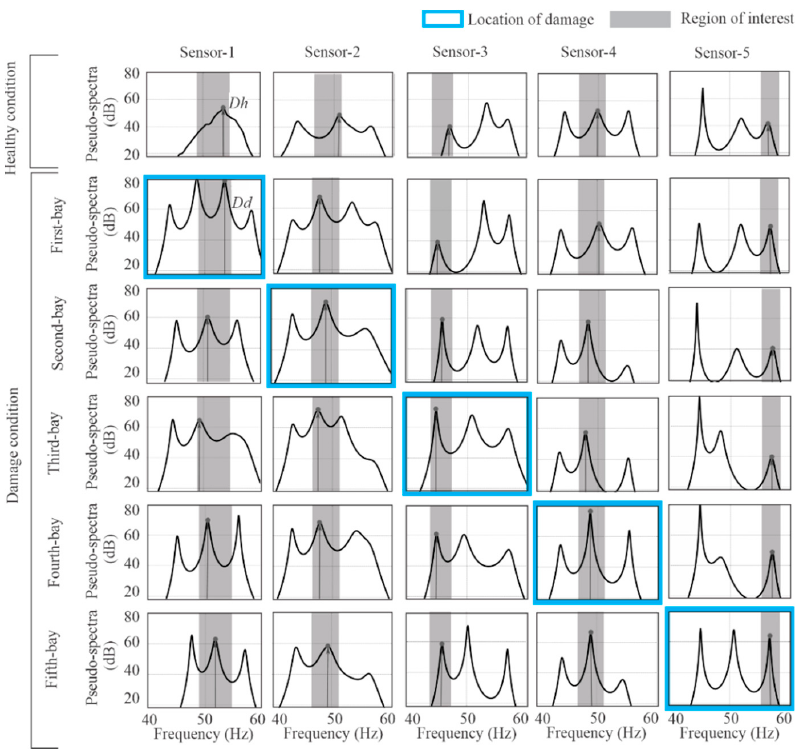
Figure 11. Pseudo-spectra obtained from the JF scenario and used to identify condition–location of damage.